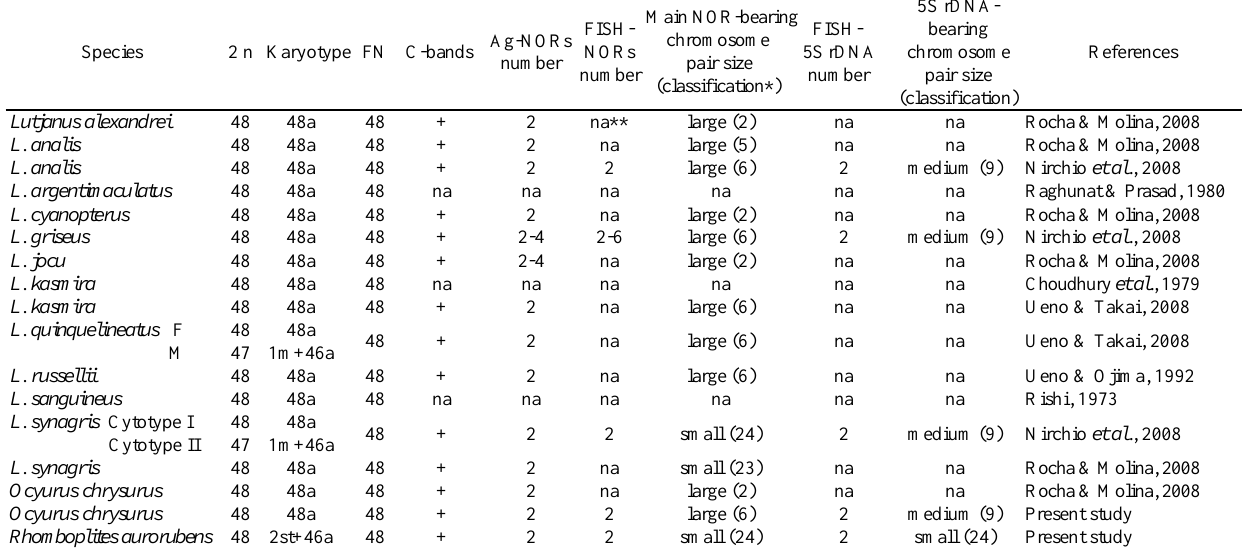
Table 1. Karyological studies in Lutjanidae (FN = Fundamental Number of chromosome arms; a = acrocentrics; m = metacentrics; M = male; F = female). *chromosome pair number as explicitly reported by the authors or as deduced from figures in the original papers; ** na = not